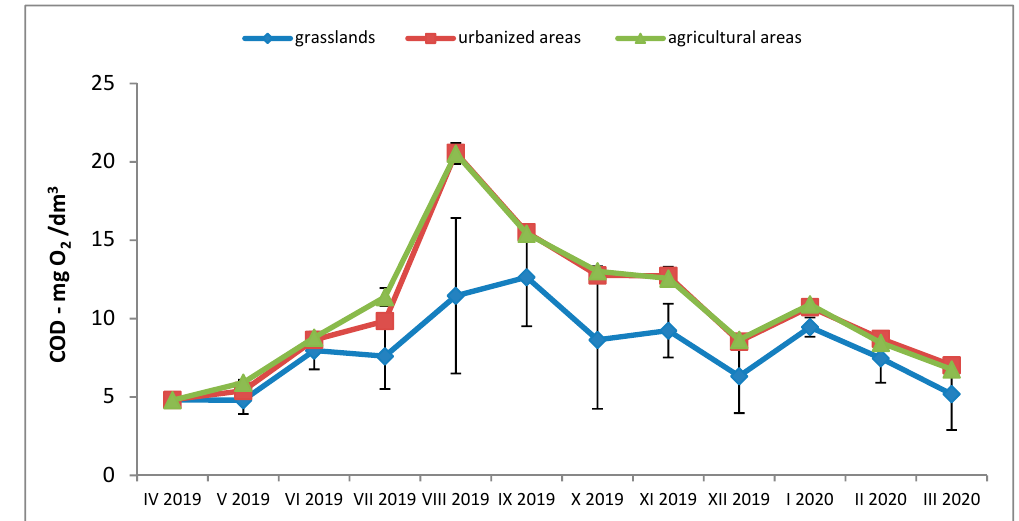
Figure 7. Mean and standard deviation for the concentration of COD in water as a function of sampling date and catchment area land use.